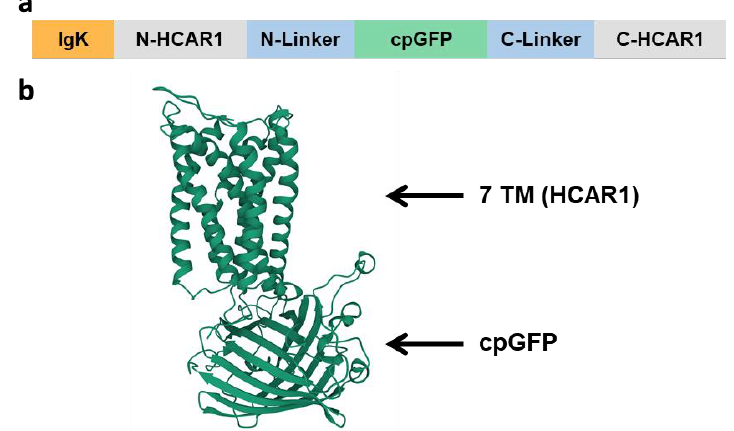
Figure 3. Design of candidate biosensors and predicted tertiary structure of the protein. ( a ) The general design of the constructs comprises a plasma membrane addressing sequence (IgK or HA) fused at the N-terminal side of the protein. cpGFP was inserted in the intracellular loop 3 and flanked with linker sequences at the N- and C-terminal side of the loop. ( b ) Tertiary structure prediction of LARS1.8 highlighting the seven-transmembrane domains (7 TM) of HCAR1 and the cpGFP insertion. For calculations of structure prediction, the disordered N- and C-termini of the sequence were trimmed to keep 15 amino acid residues before the start of transmembrane domain 1 and 10 residues after transmembrane domain 7 on N-terminal side. The structure prediction yielded an overall high level of confidence ( p = 0.0024).